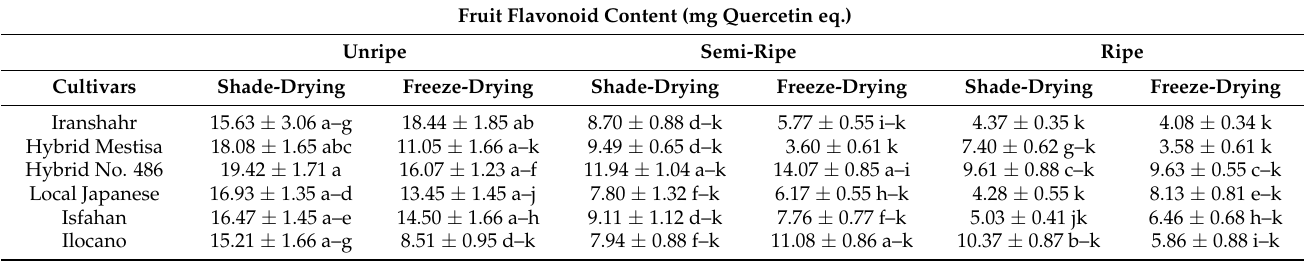
Table 7. Fruit flavonoid content of six cultivars of bitter melon (mg quercetin equivalent). Fruit Flavonoid Content (mg Quercetin eq.)